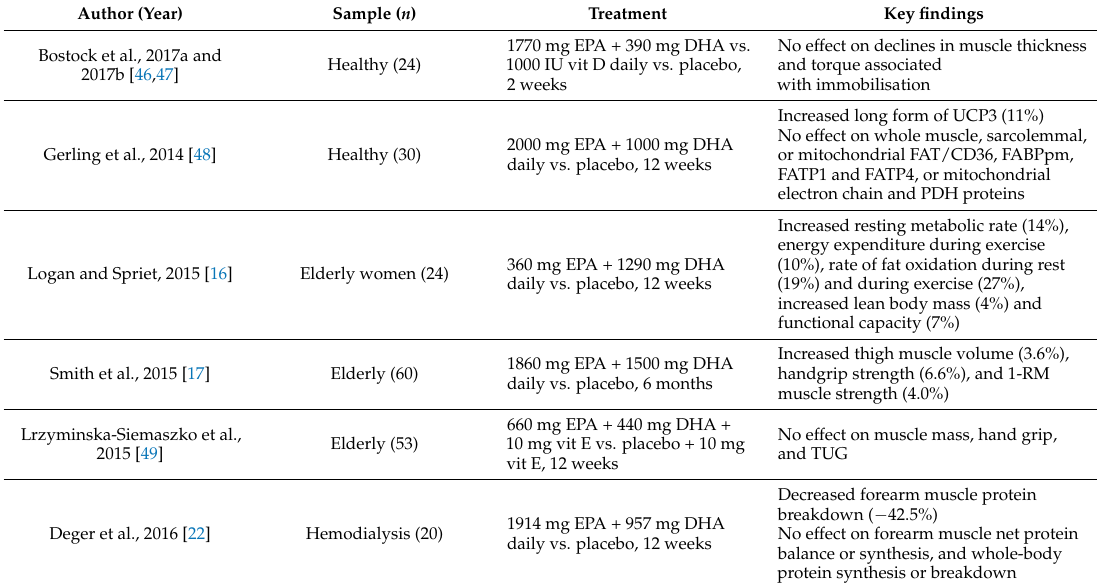
Table 5. Muscle mass and function, and whole-body